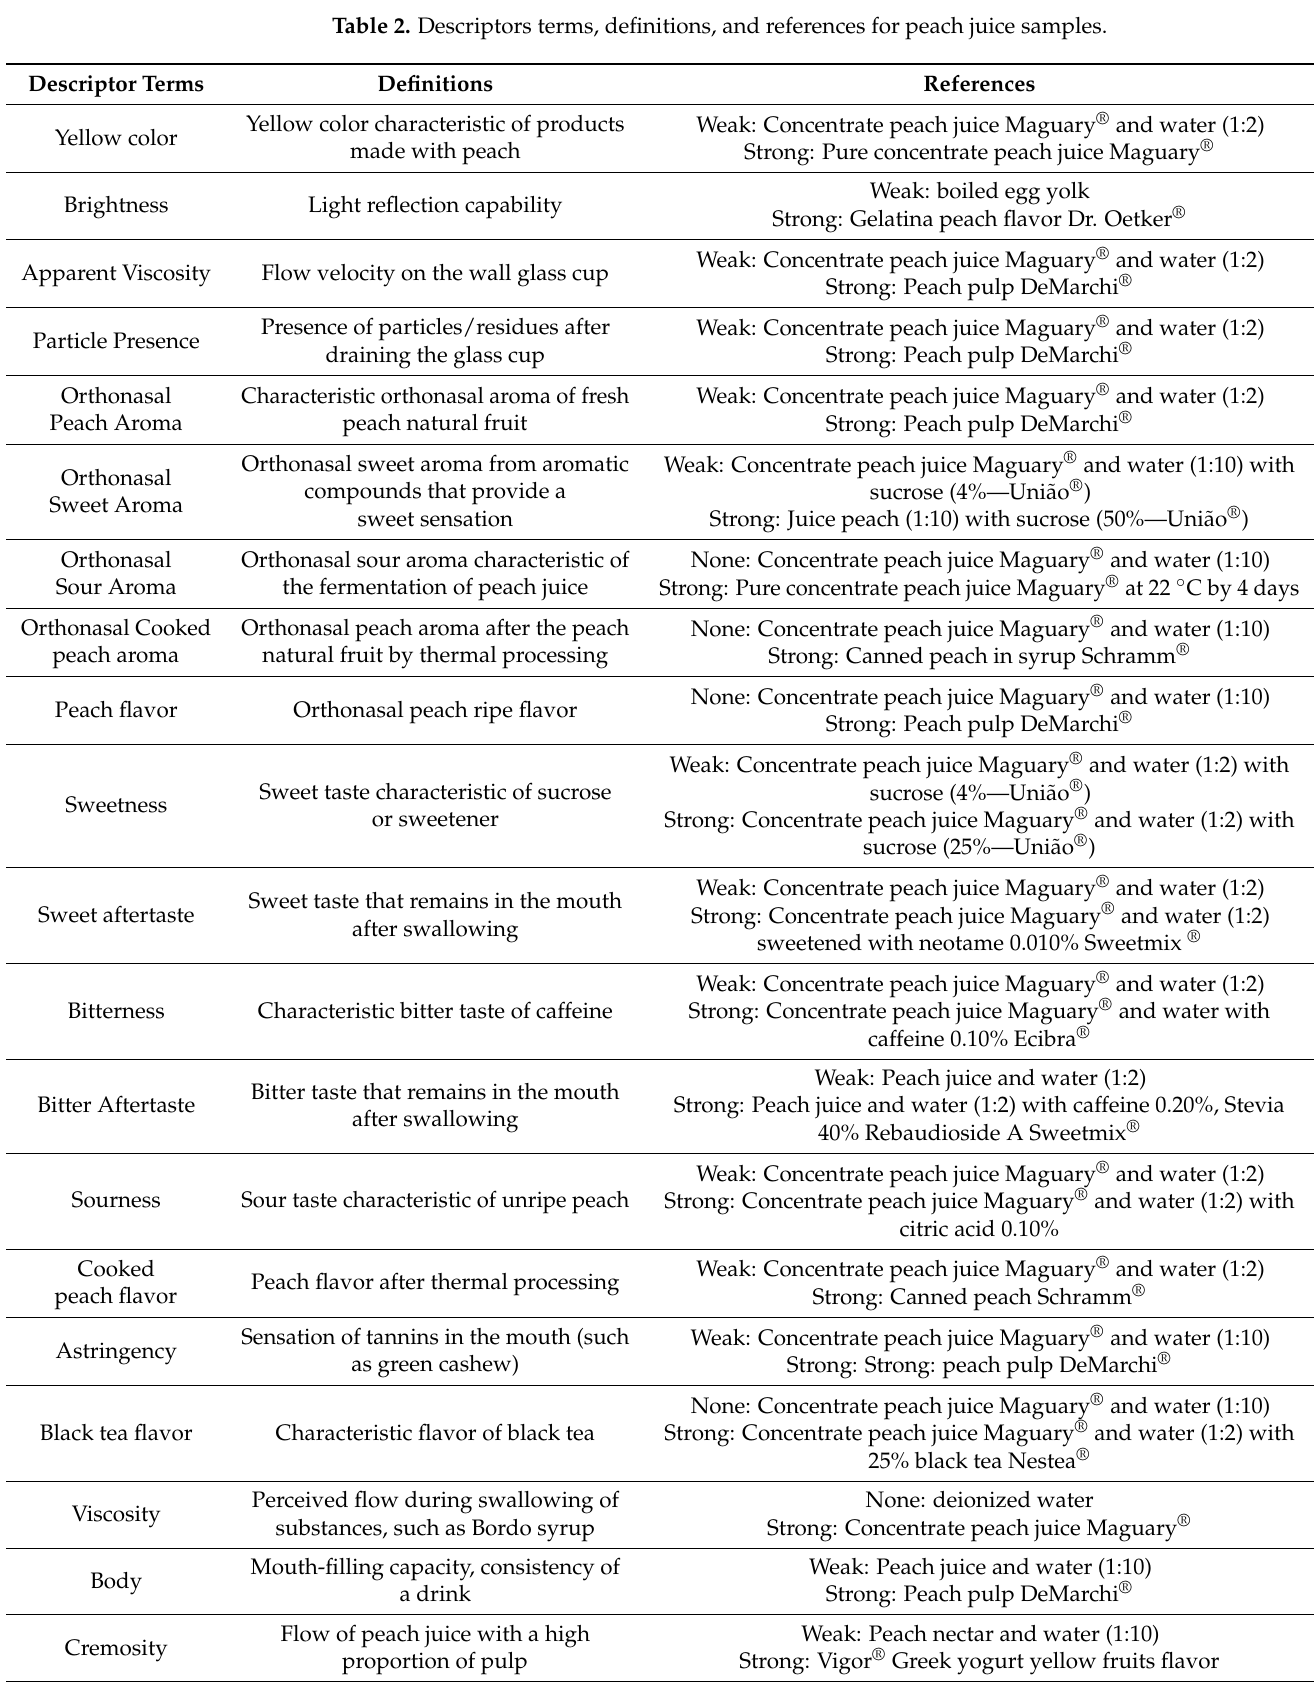
Table 2. Descriptors terms, definitions, and references for peach juice